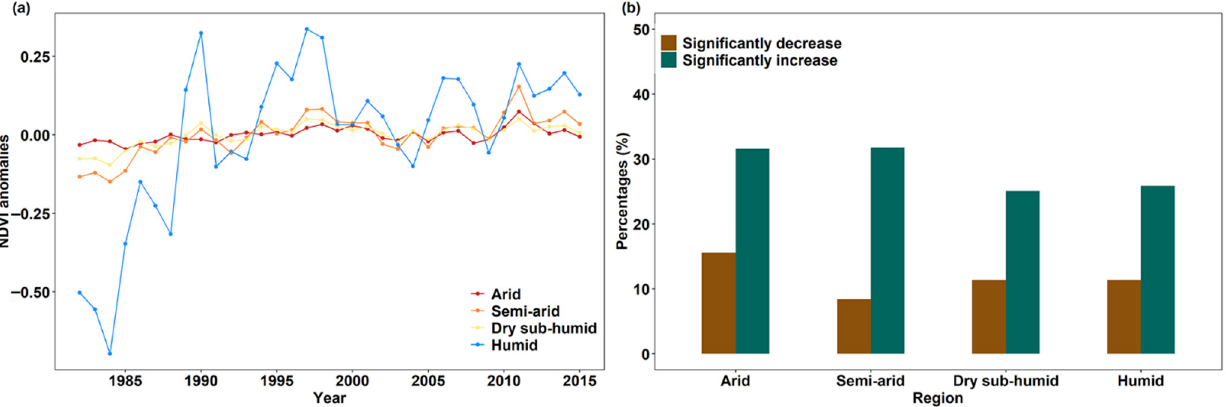
Figure 3. Vegetation changes for different dry-wet regions. ( a ) The interannual variations and ( b ) the percentage of grids showing significant changes in NDVI for different dry and wet regions during 1982–2015.